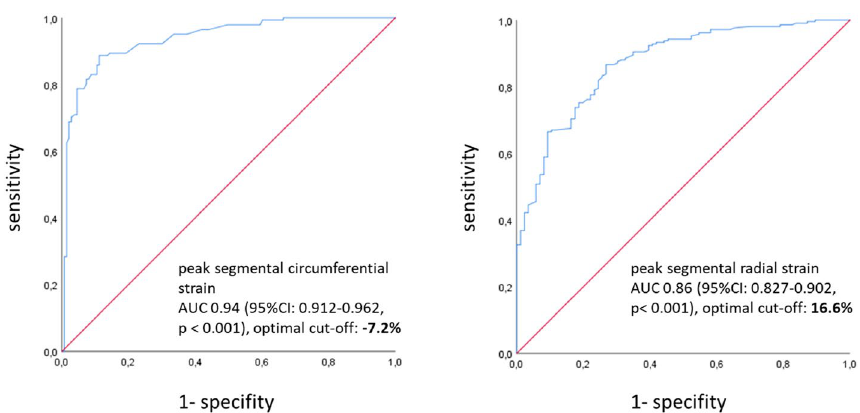
Figure 4. ROC curves for distinguishing infarcted and remote myocardium based on strain parameters. In SPCS the optimal cut-off is − 7.2% (sensitivity of 89.4% and specificity of 85.7%) and in SPRS the optimal cut-off is 16.6% (sensitivity of 83.3% sensitivity and specificity of 76.5%). ROC Receiver operating characteristic, SPCS segmental peak circumferential strain, SPRS segmental peak radial